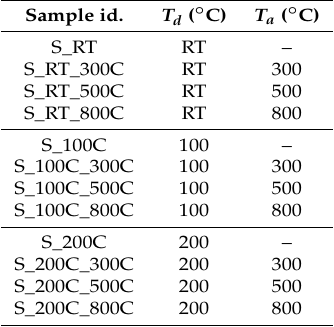
Table 1. Temperatures of deposition ( T d ) and annealing ( T a ) for the investigated samples. Sample